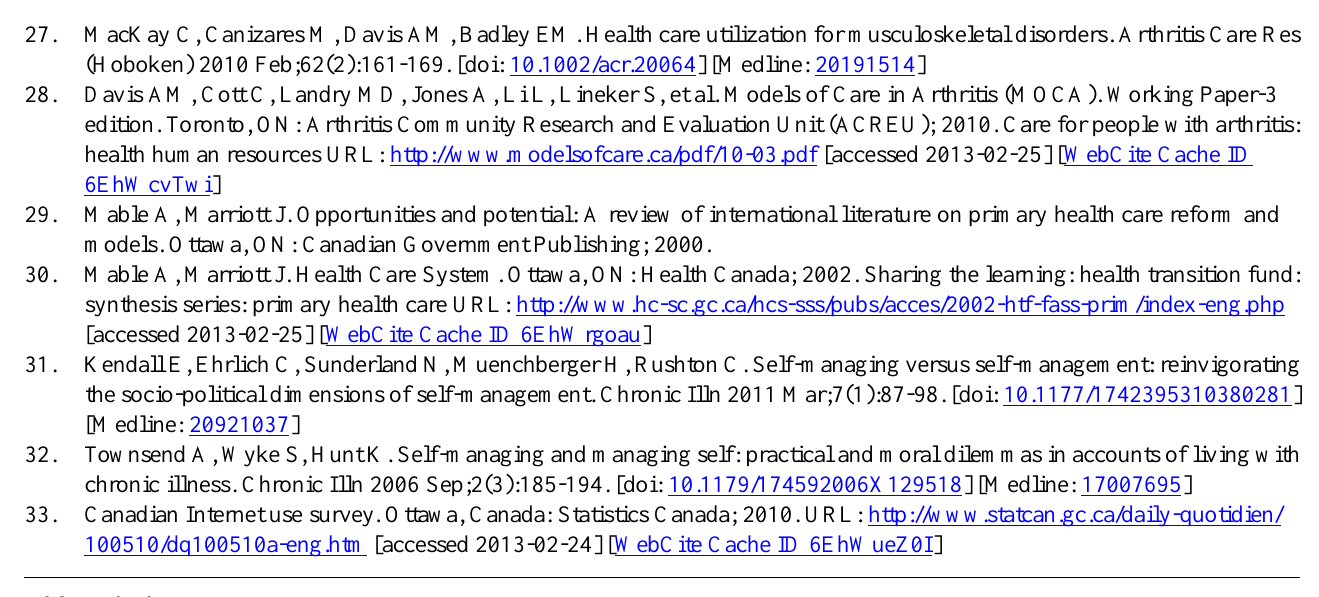
CIHR: Canadian Institutes of Health Research MSK: